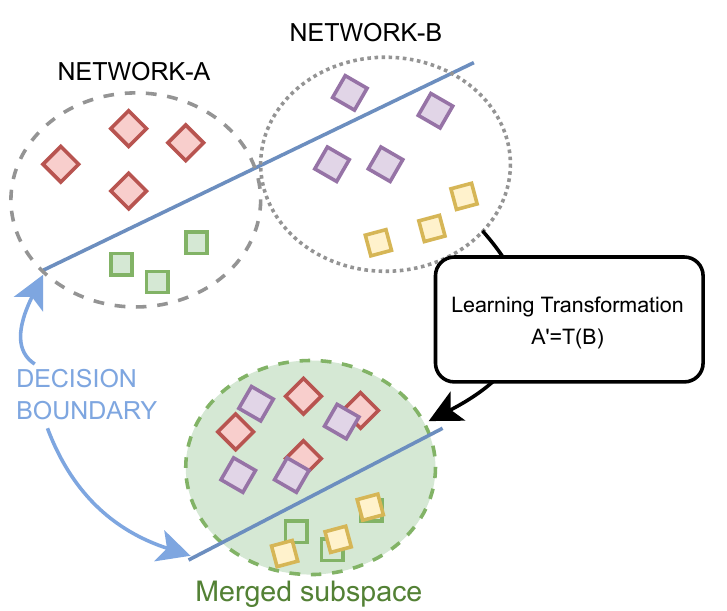
Figure 2. Model transfer—general overview of domain adaptation for traffic recorded for Network B to feature space of Network